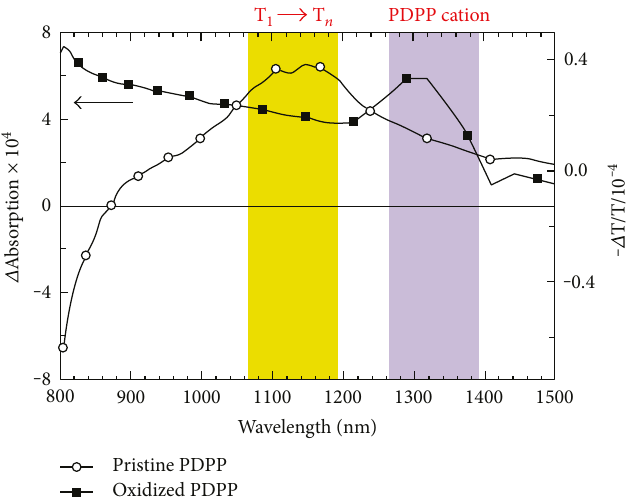
Figure 2: Triplet-triplet absorption and radical cation absorption of the PDPP polymer (converted to wavelength scale; data taken from